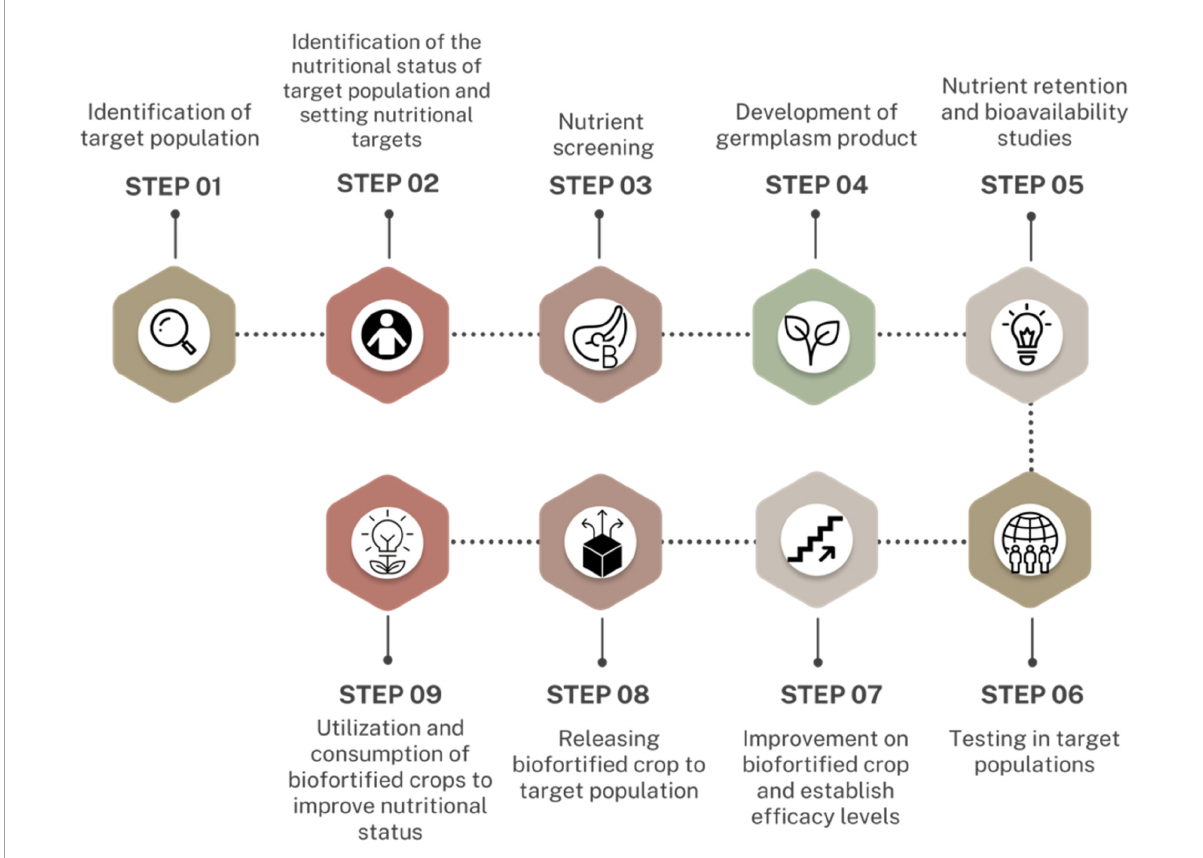
FIGURE3 Harvest plus impact pathway–Plant-based biofortification steps [Modified from